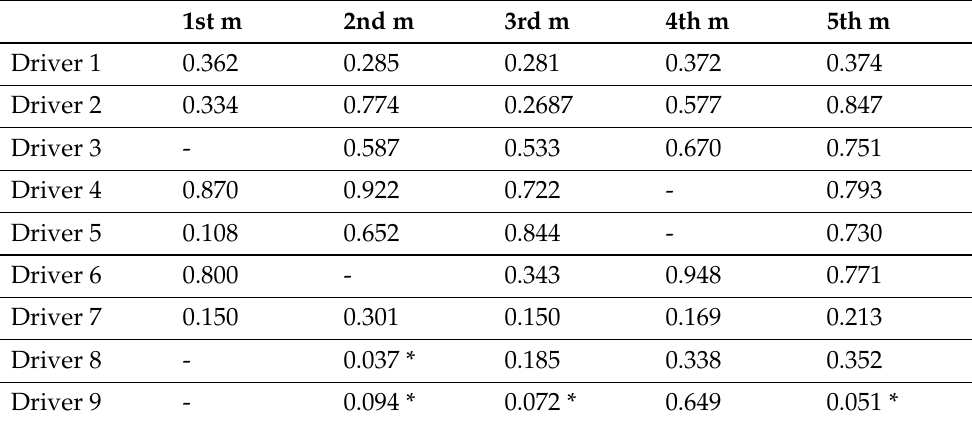
Table 3. Average p -value for speech signal with regard to time (minute) for Experiment 2 ( p -value below the threshold of 0.10 is marked using *).